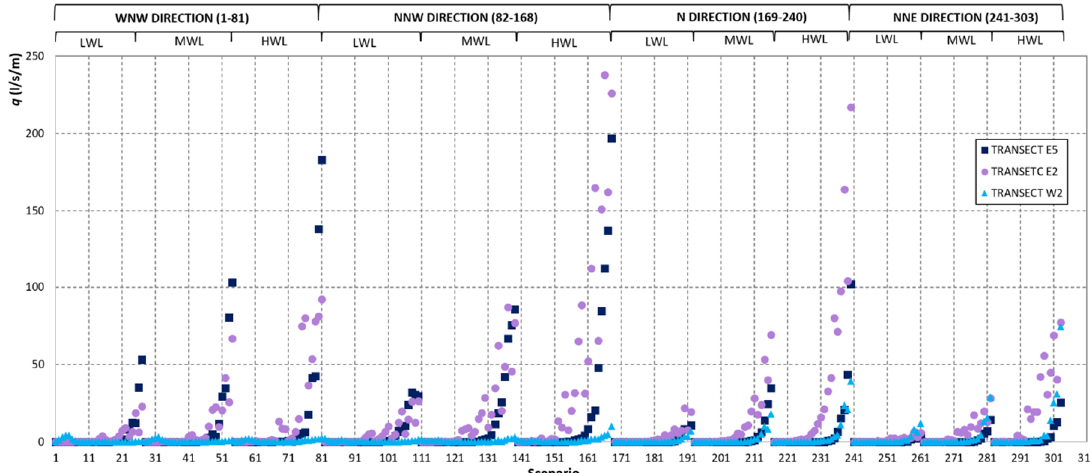
Figure 8. Wave overtopping in three transects E5 (dark blue squares), E2 (purple dots) and W2 (light blue triangles) for 303 selected sea state events.